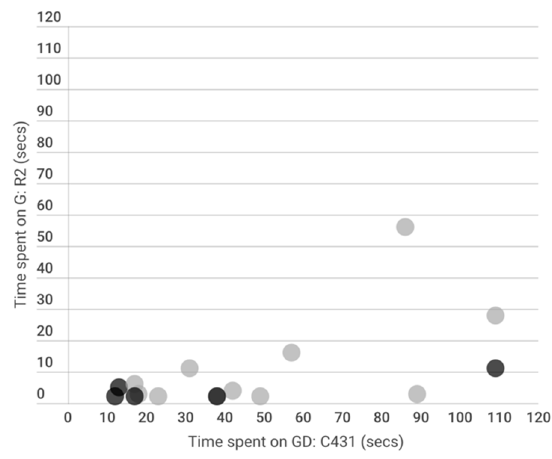
Figure 6. Scatterplot of correlation between the ‘time spent’ variables of GD on C431 and G on R2. Black circles represent students with low exponential growth knowledge gain, and grey circles represent high gain students.